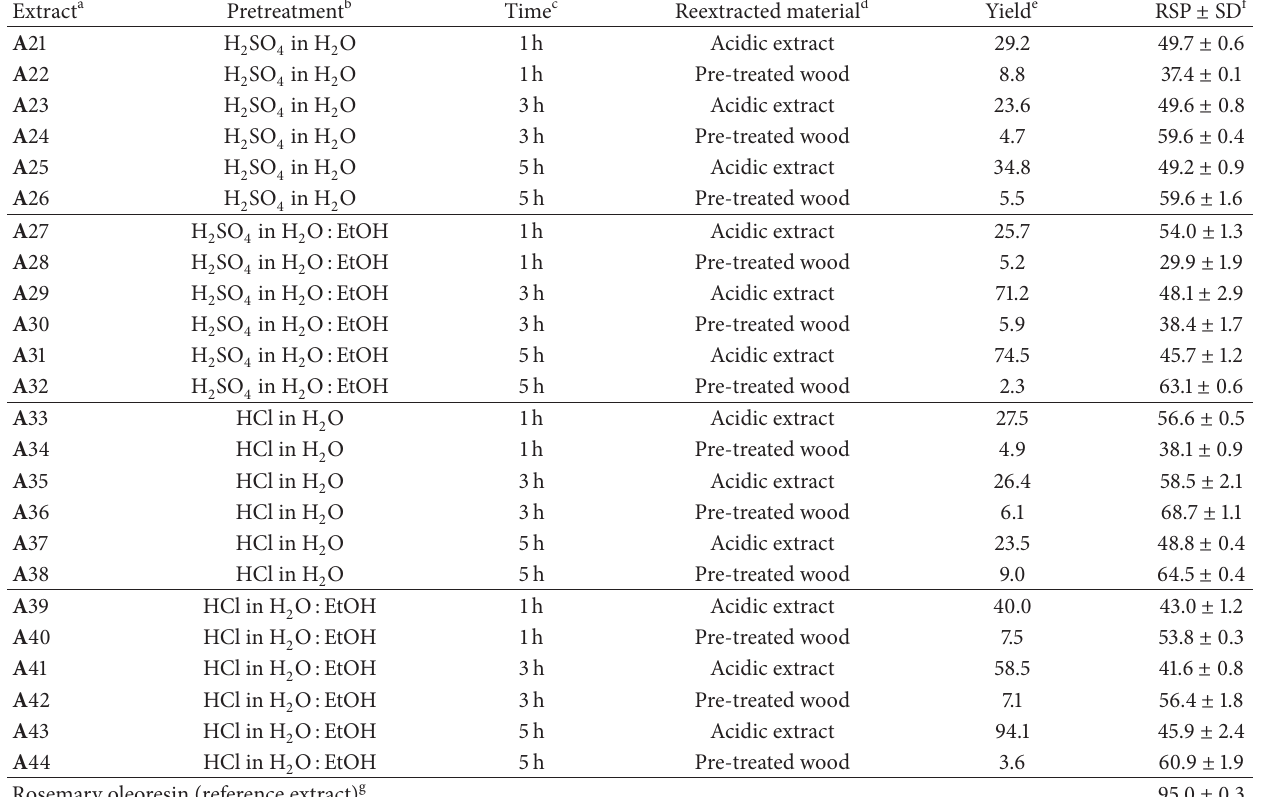
Table 3: Extraction yields and radical scavenging percentages of several extracts prepared by the extraction procedure E7 from the olive wood sample A